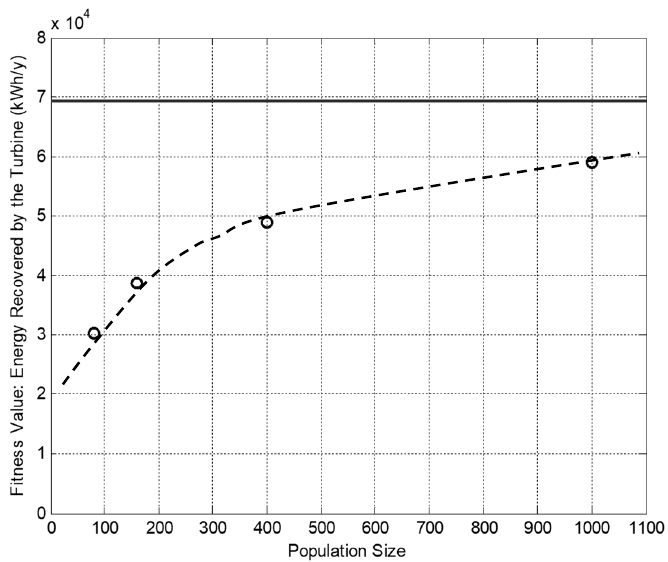
Figure 6. Fitness values of the smart seed and the genetic algorithm (GA) outputs for different population sizes.